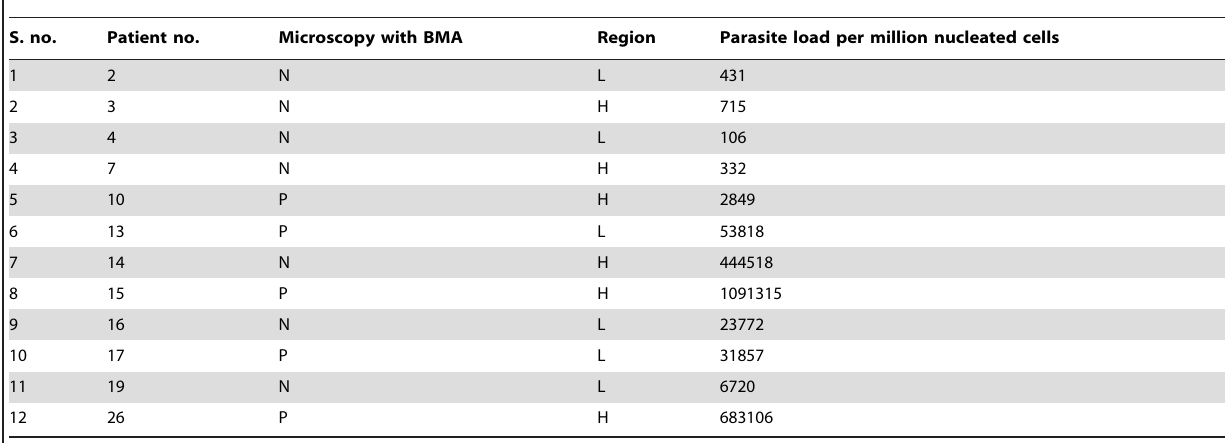
Table 2. Results of real-time PCR assay for Leishmania DNA in BMA samples of VL patients.